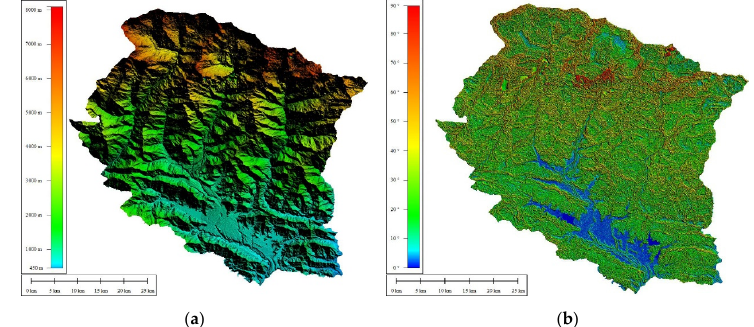
Figure 3. Maps obtained from shuttle radar topography mission (SRTM) dem: ( a ) elevation; ( b )